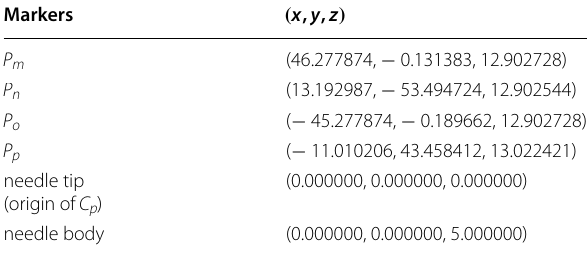
Table 2 The calibrated coordinate values.